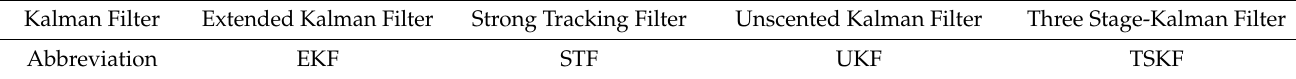
Table 1. Abbreviation of Kalman filter